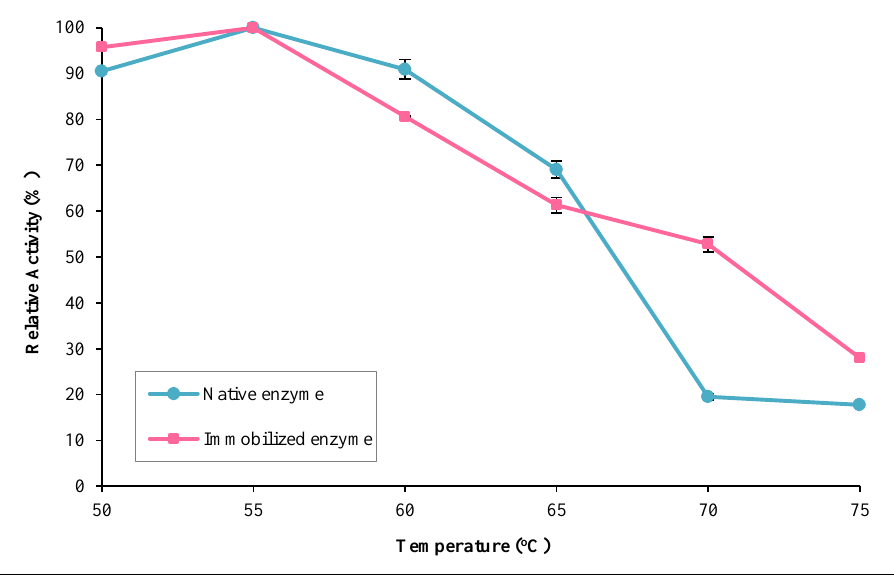
Figure 4. Optimum temperature of the native and immobilized enzymes (mean ± SD; n = 2; p <